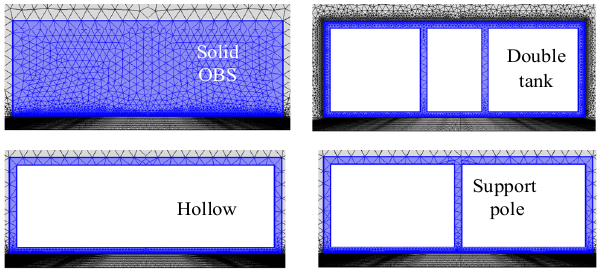
Figure 20. The cylindrical OBSs with same average density but different internal compartments.